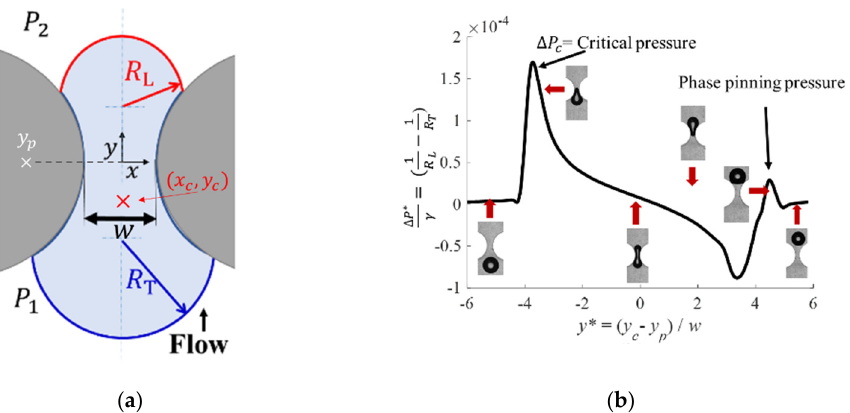
Figure 1. ( a ) Schematic of bubble deformation and ( b ) an example of the determined pressure difference across an isolated bubble passing through a pore and its corresponding locations.